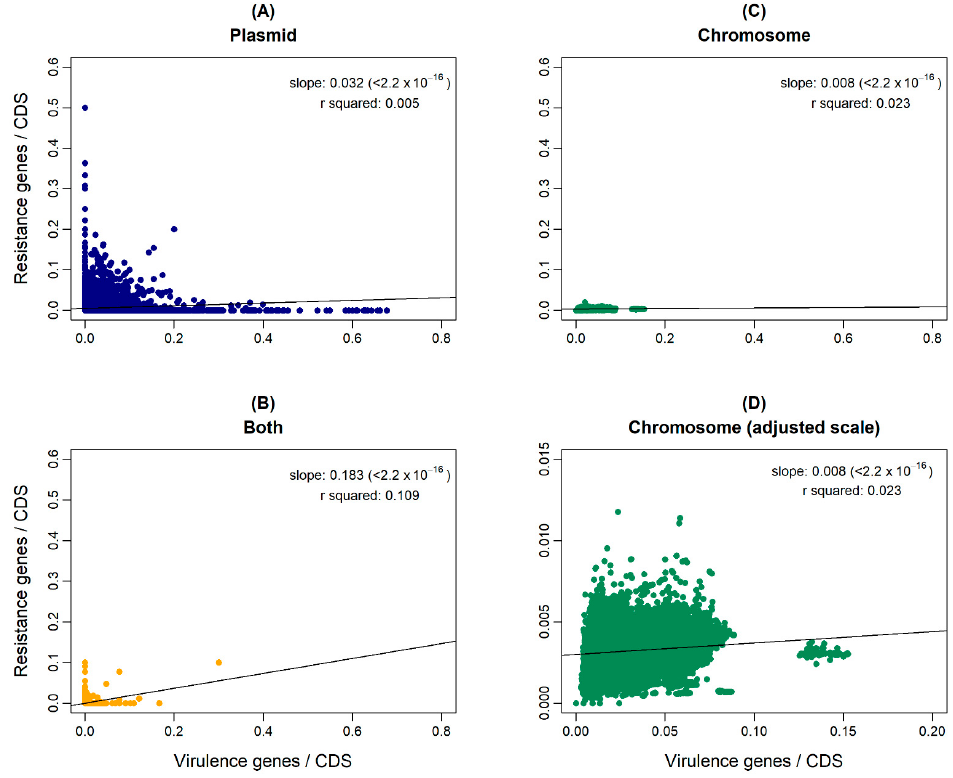
Figure 5. Relationship between antibiotic resistance gene orthologues of the ResFinder database (vertical axes) and virulence gene orthologues of the VFDB (horizontal axes). To correct for the size of the corresponding locations, the number of resistance and virulence genes in each genome was divided by the amount of coding DNA sequences (CDS) in that genomic location. Each point repre- sents a genome. The colors indicate the genomic location: plasmid (blue), chromosome (green), or ‘both’ (yellow). ( C , D ) show the same data; however, ( D ) has the scale adjusted to better demonstrate the distribution of points. In ( A ), plasmid location (R = 0.005, slope = 0.032, p -value = ~0). In ( B ), both locations (R = 0.109, slope = 0.183, p -value = ~0). In ( C , D ), chromosome location (R = 0.023, slope = 0.008, p -value = ~0).